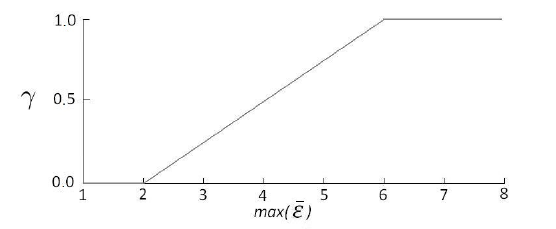
Figure 26. Confidence parameter for longitudinal